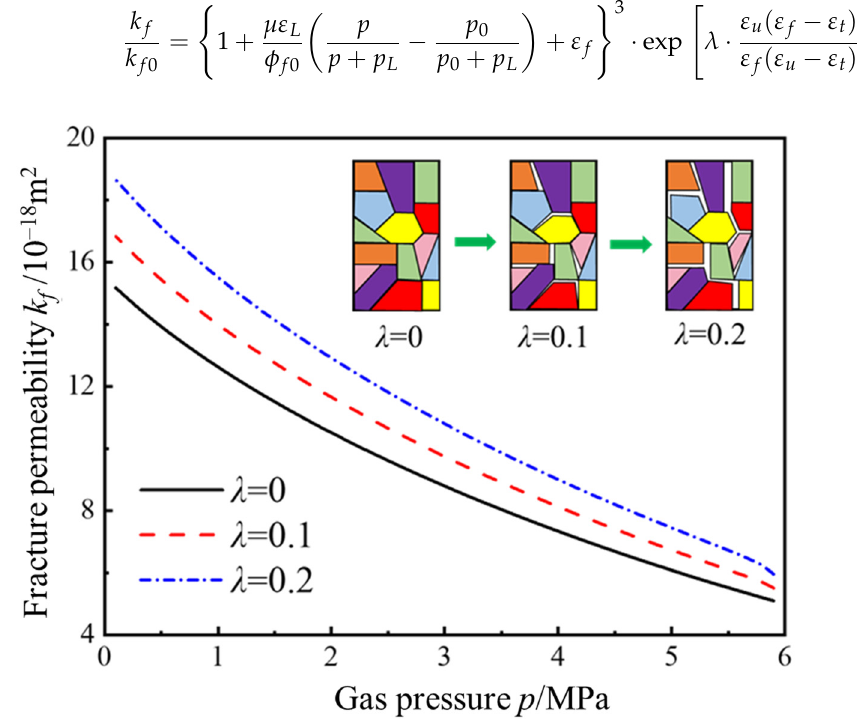
Figure 10. The effect of permeability–damage coefficient on fracture